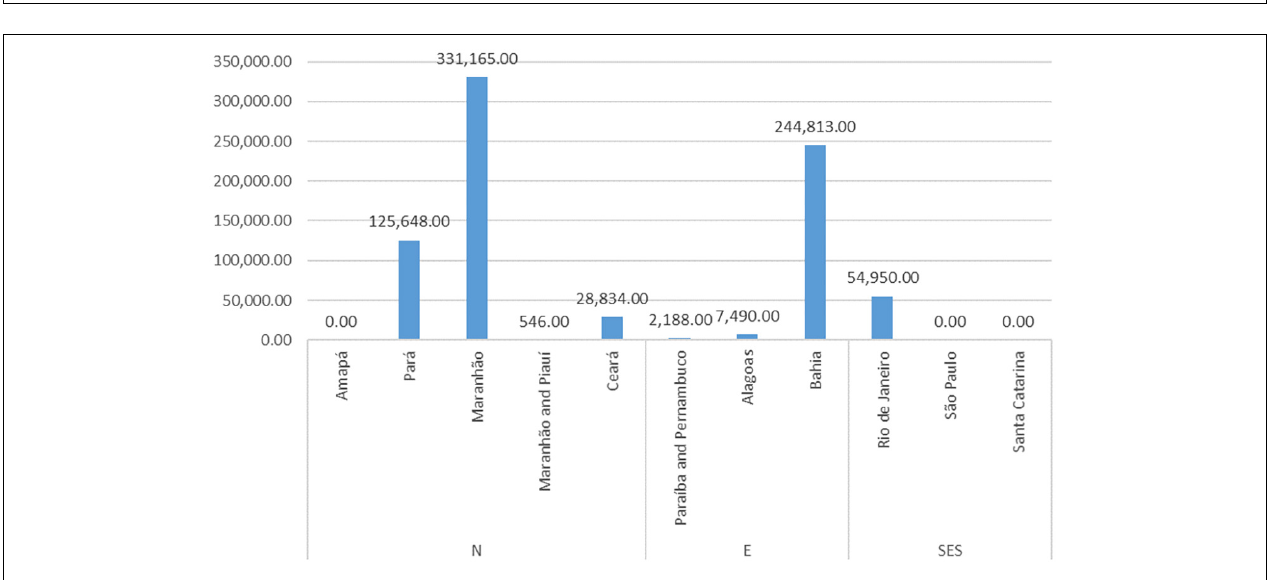
FIGURE 16 | Total marine extractive reserves areas for Brazilian coastal states (ha). Elaborated by the authors with data from the Painel Unidade de Conservação Brasileiras—Ministério do Meio